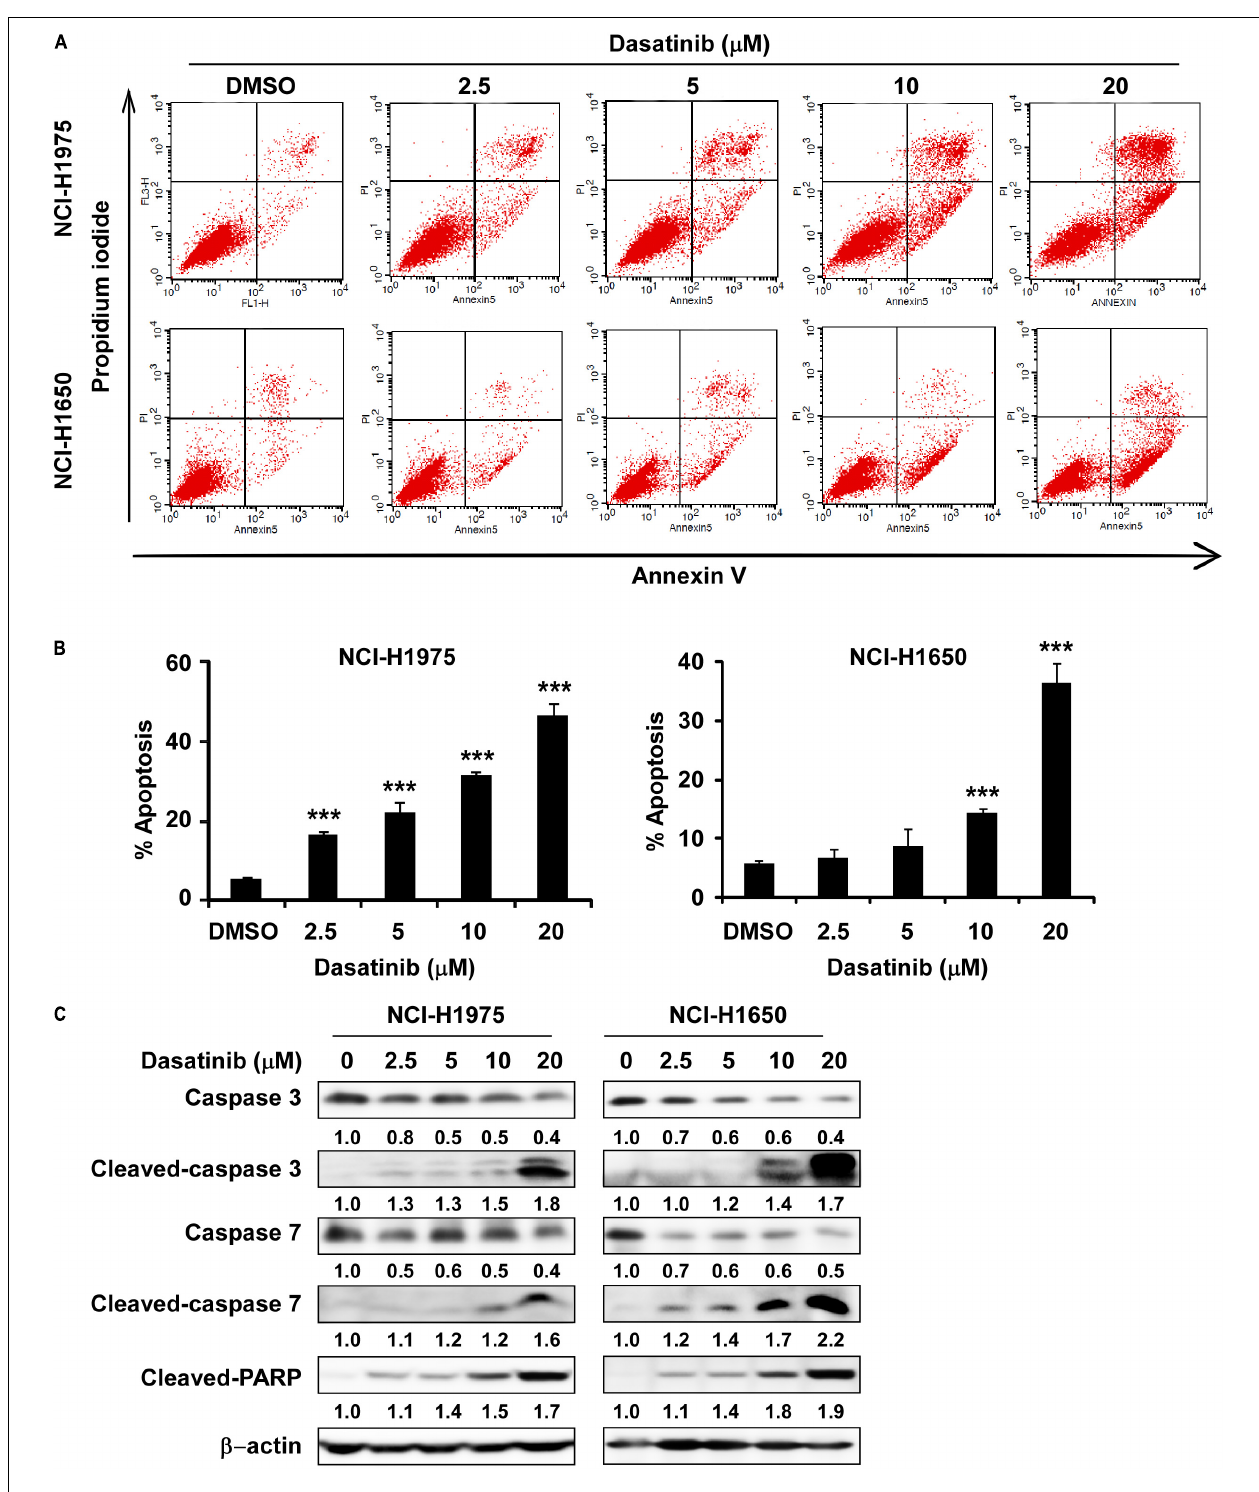
FIGURE 4 | Dasatinib induces cell apoptosis. (A) Dasatinib treatment induced cell apoptosis. (B) Dasatinib treatment can induce cell apoptosis in a concentration dependent manner. (C) Dasatinib upregulated the expression of cell apoptosis markers like cleaved-PARP, cleaved-caspase3 and 7 by determined with Western blotting. The asterisks (* p < 0.05, ** p < 0.01, *** p < 0.001) indicated a significant difference between untreated control and dasatinib-treated cells. Data were shown as means ± SD of values from triplicate samples and similar results were obtained from three independent experiments.